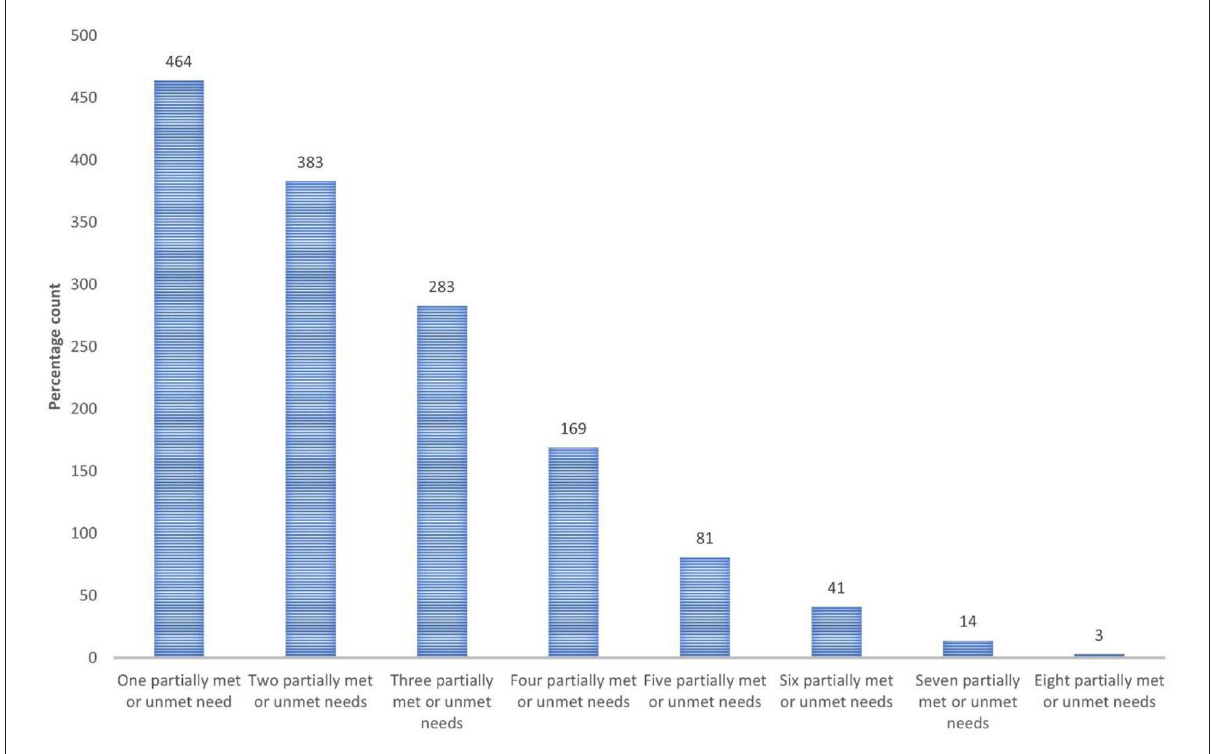
FIGURE2 Frequency of partially met or unmet needs reported by participants who wanted